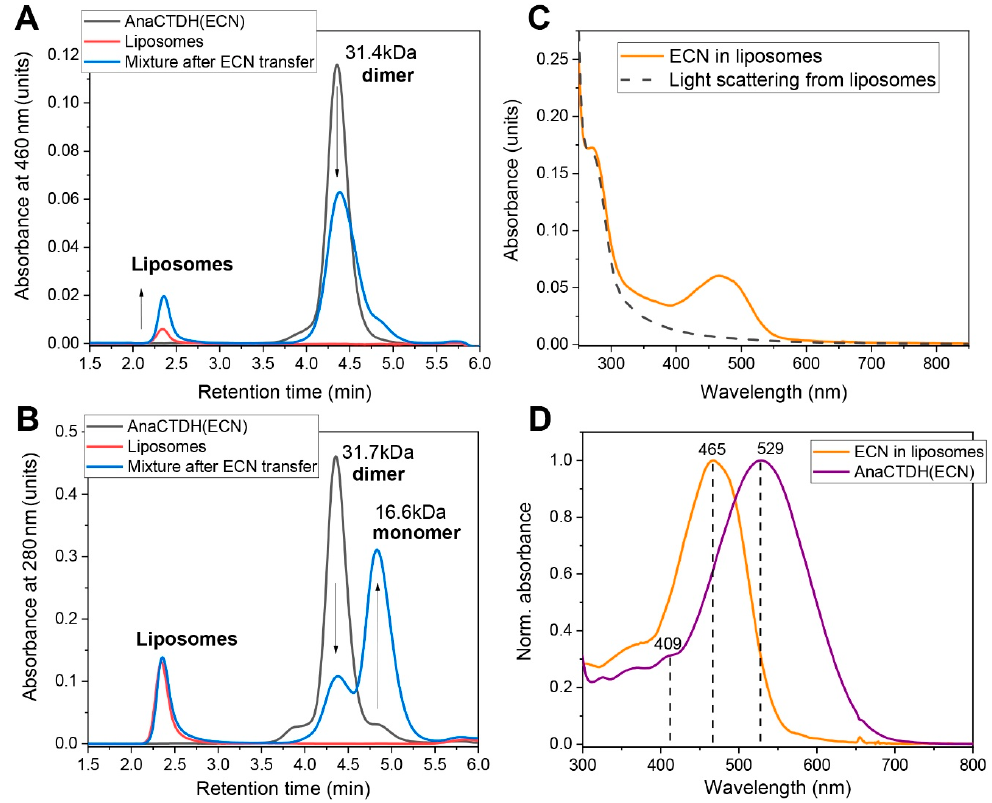
Figure 4. Carotenoid delivery from AnaCTDH(ECN) holoprotein to liposomes studied by size-exclusion spectrochromatography. ( A , B ) Elution profiles of AnaCTDH(ECN), liposomes, or their mixture pre-incubated for 40 min at 30 °C to ensure carotenoid transfer, followed by either 460 nm ( A ) or 280 nm ( B ) absorbance, using a Superdex 200 Increase 5 / 150 column (GE Healthcare) operated at a 0.45 mL / min flow rate by a Varian ProStar 335 diode-array system with the full spectrum absorbance detection. Apparent Mw for the protein peaks was estimated from column and give significant light scattering. Arrows indicate the observed changes as the result of